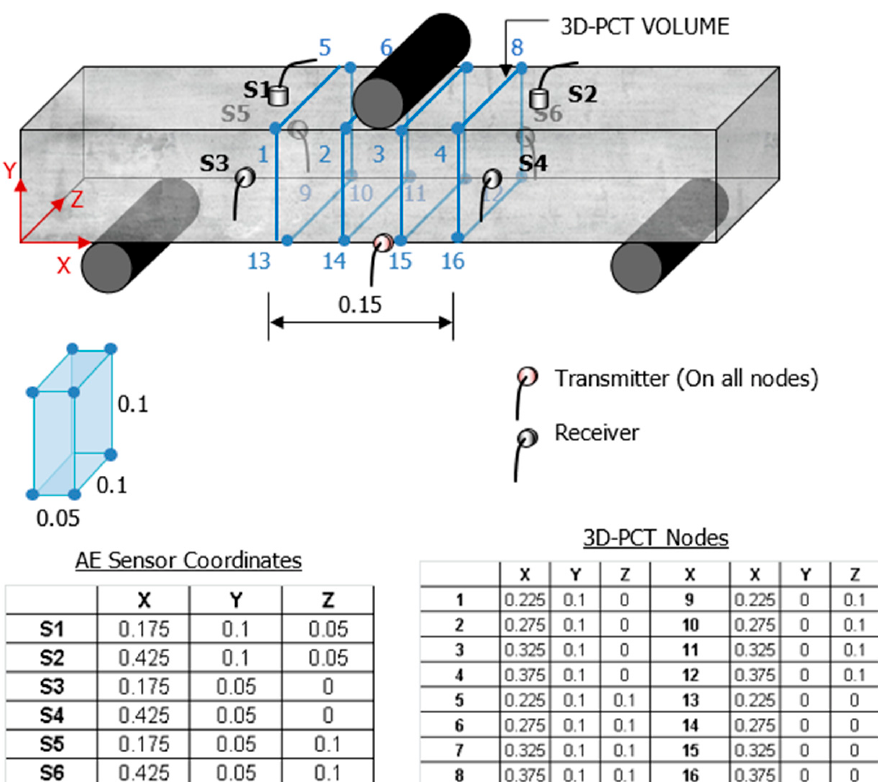
Figure 3. 3D-PCT test setup (Unit: m).